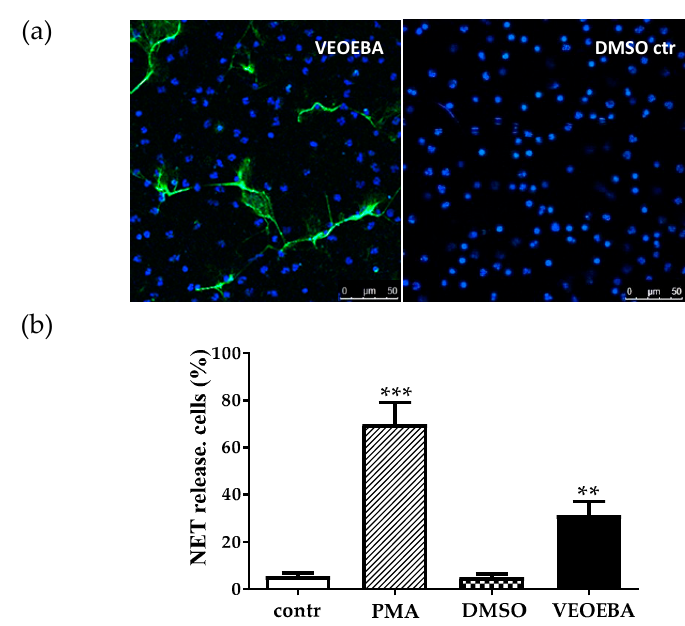
Figure 4. VEOEBA significantly induces the NET formation of human neutrophils after 4 h of incubation, compared to DMSO control. Depicted in ( b ) are the percentages of NET-releasing cells compared to total amount of neutrophils from a minimum of n = 4 independent experiments. Representative images are shown in ( a ). NETs were visualized using double-staining with 4 (cid:48) ,6 (cid:48) -diamidino-2-phenylindole (DAPI) to stain DNA ( blue ), and monoclonal mouse anti-H2A-H2B-DNA complex antibody followed by an Alexa 488-rabbit anti-mouse antibody ( green ). ** p < 0.005, *** p < 0.001 one-tailed, paired Student’s t -test.